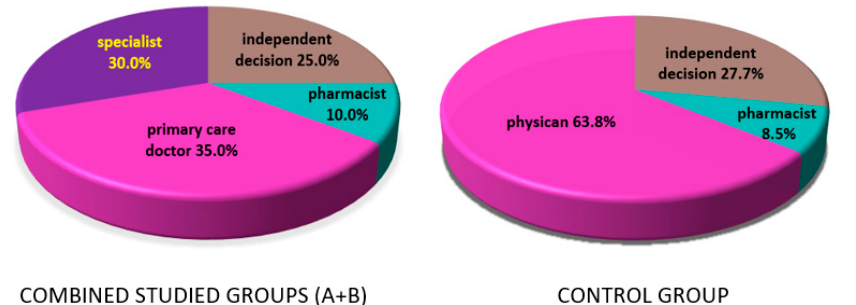
Figure 5. Sources of information on vitamin D supplementation in women treated for breast cancer before joining the program (combined group A in winter and group B in summer)— left disc; and in healthy control group— right disc. The detailed percentages are listed in the figure.